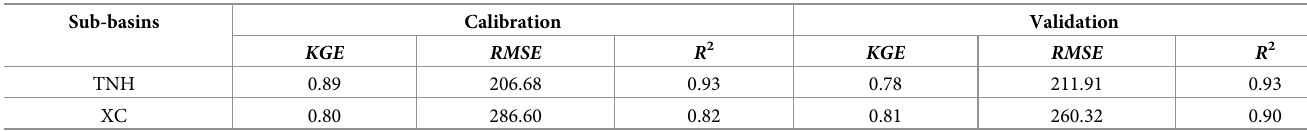
Table 3. Accuracy evaluation results of the SIMHYD-SNOW model. Sub-basins